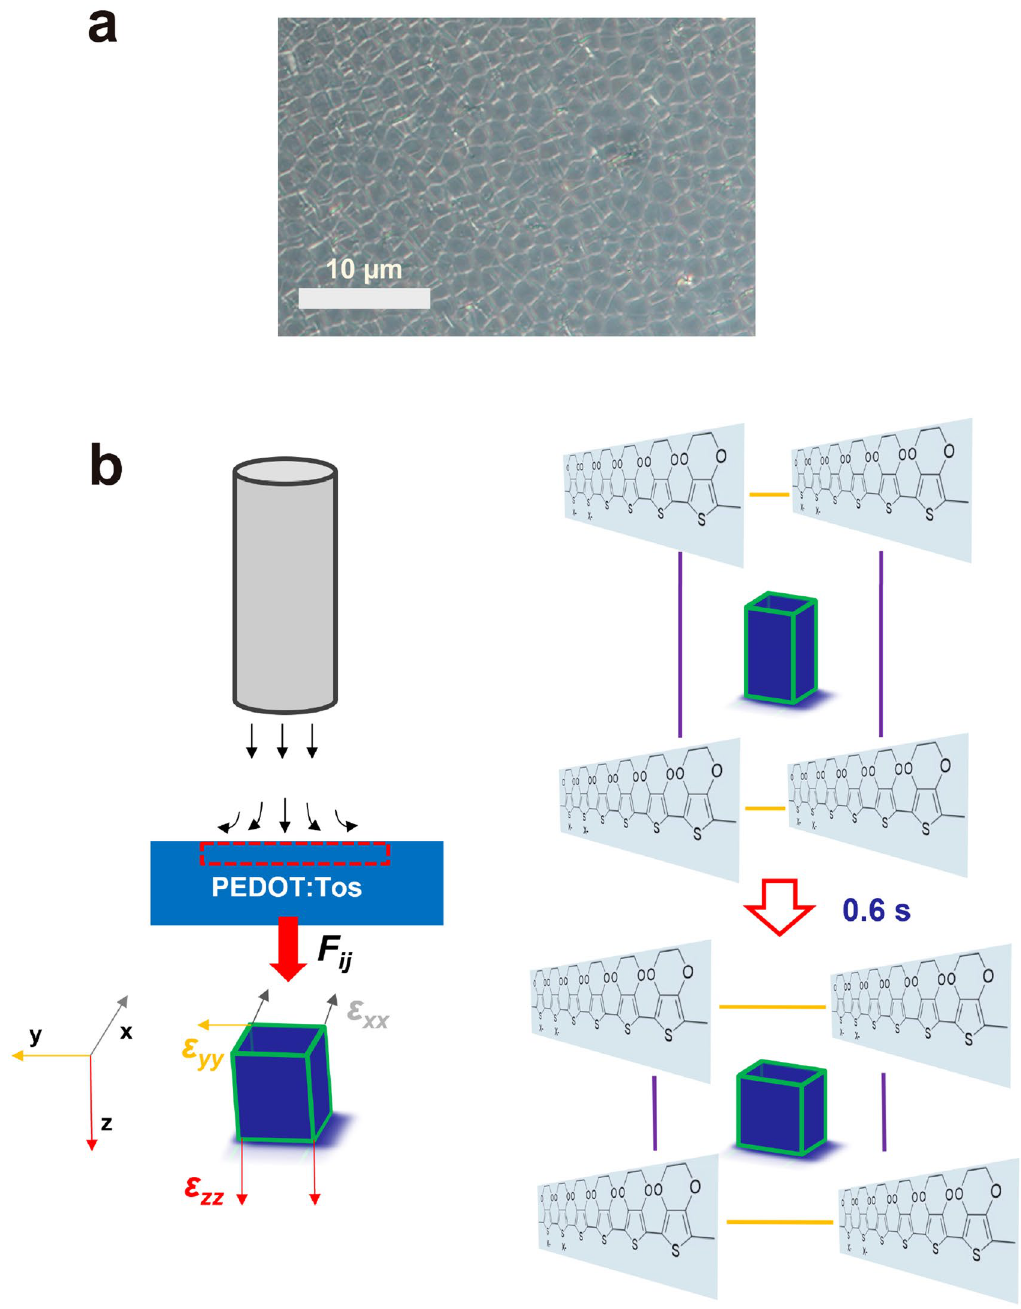
Scheme 1. ( a ) Optical spectroscopy of the PEDOT:Tos thin film with the doping level of 43.6%; ( b ) the proposed deformation of the PEDOT crystal cell under the gas flow